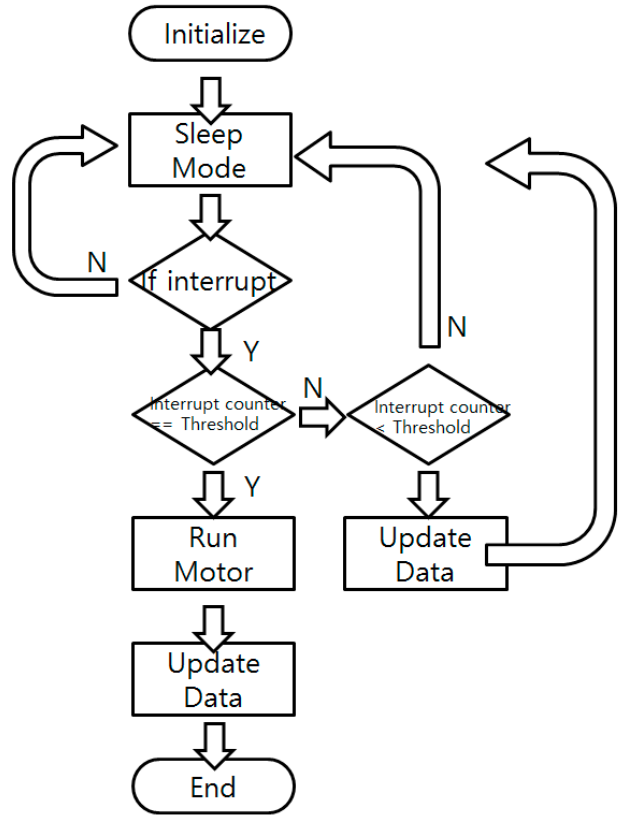
Figure 7. Software flow chart of the main sensor node.